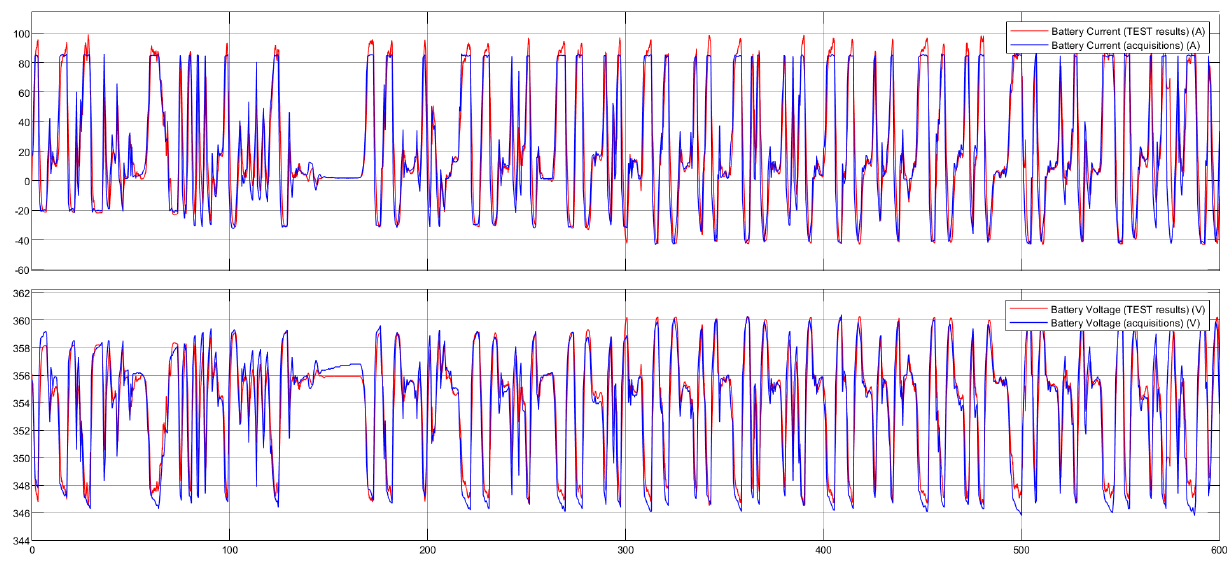
Figure 10. Battery current (in Ampere, first graph) and the battery voltage (in Volt, second graph) vs. lap time expressed in seconds. In particular, in the figure, there are the battery current and voltage resulting from the calibrated model (in red) and the battery current and voltage acquired through the VCU of the waste collection vehicle prototype (in blue).